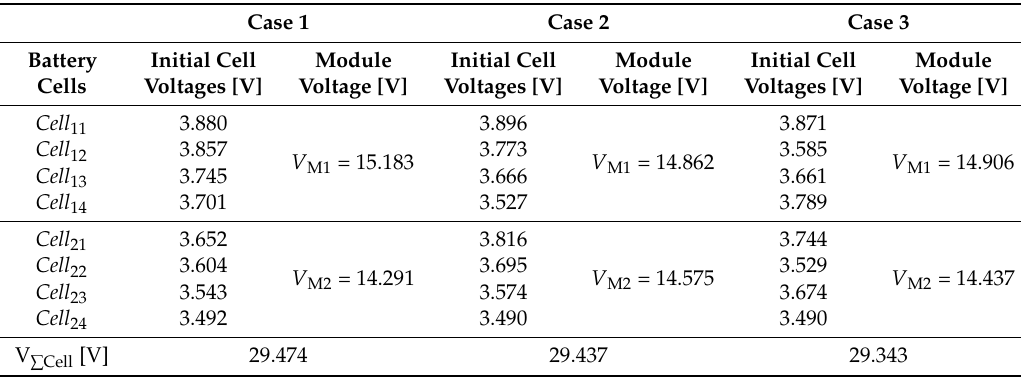
Table 2. The initial voltages of the cells for the experiment.